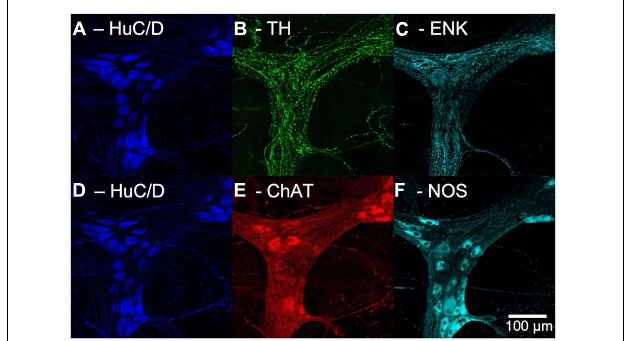
FIGURE 1 | Confocal images of multi-layer immunohistochemistry of a single ganglion in the myenteric plexus of human colon. Panels (A–C) show the first layer of immunohistochemistry. (A) Human RNA binding proteins C and D (HuC/D), a marker for neuronal cell bodies, shown in blue. (B) Tyrosine Hydroxylase (TH) a marker for noradrenergic varicosities, in green. (C) Enkephalin (ENK) varicosities, in cyan. Panels (D–F) show the second layer of immunohistochemistry. (D) HuC/D labelling is retained after elution due to the high affinity Biotin-Streptavidin bond. (E) Choline acetyltransferase (ChAT), a marker for cholinergic neurons, shown in red. (F) Nitric oxide synthase (NOS), a marker for nitrergic neurons, shown in